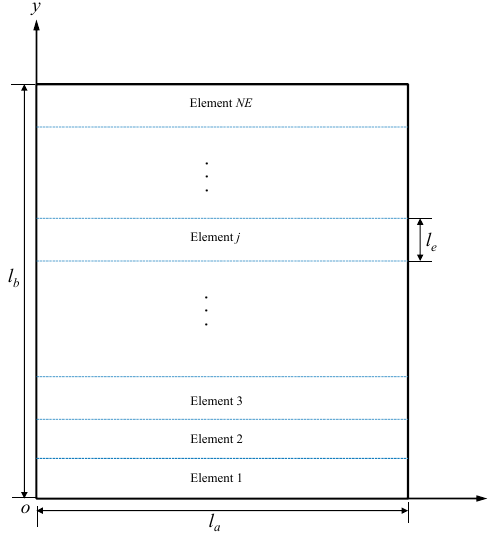
Figure 2. Strip elements for a rectangular nanoplate.